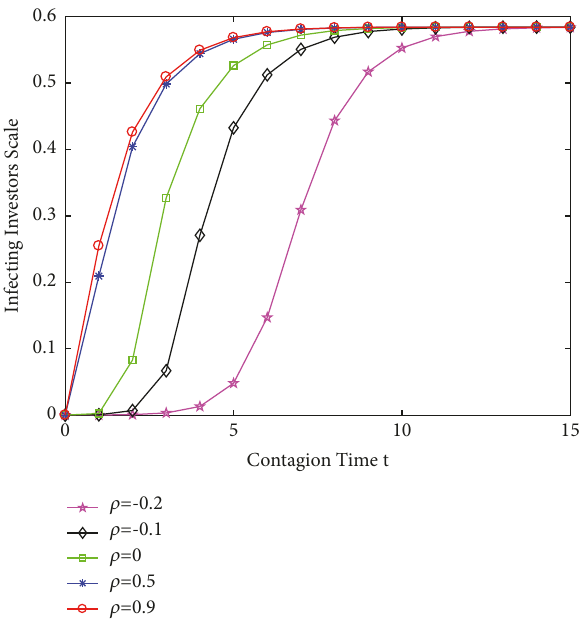
Figure 14: Comparison of investor risk contagion in the stock mar- ket under different connection modes of bilayer-coupled networks.